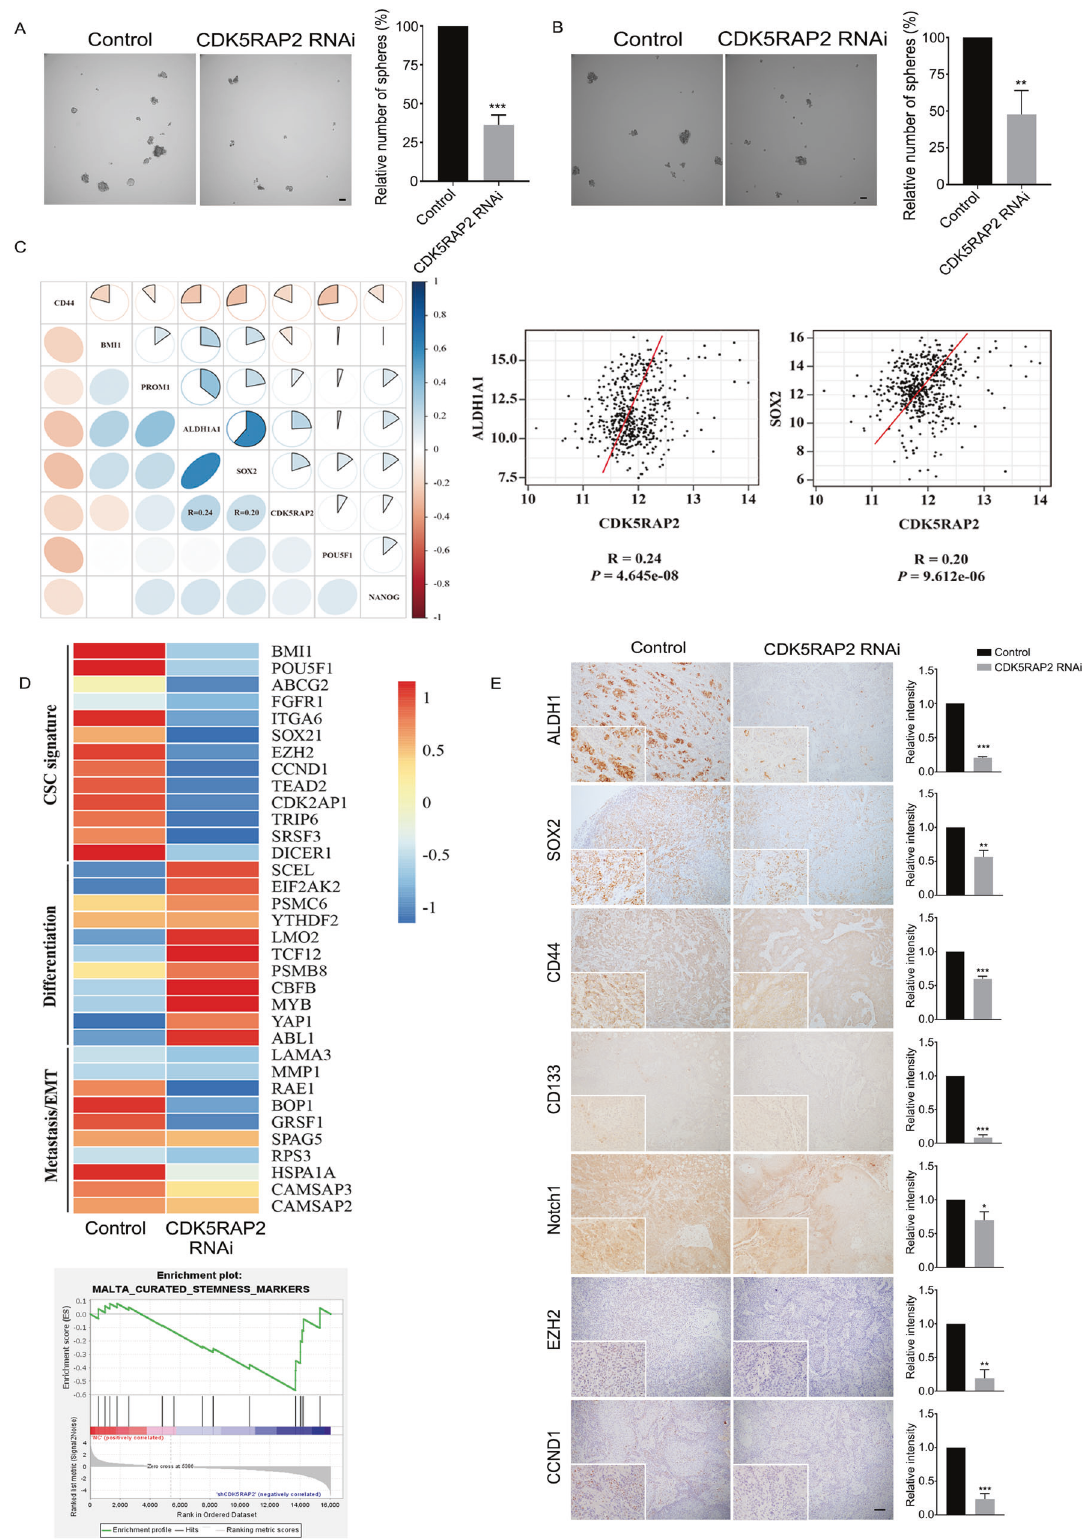
regulated by the Wnt signaling pathway; (3) CDK5RAP2 knockdown inhibits the tumorigenesis and migration of OSCC cells; and (4) CDK5RAP2 is found to be involved in maintaining the CSC signature of OSCC cells and in the regulation of spindle orientation.